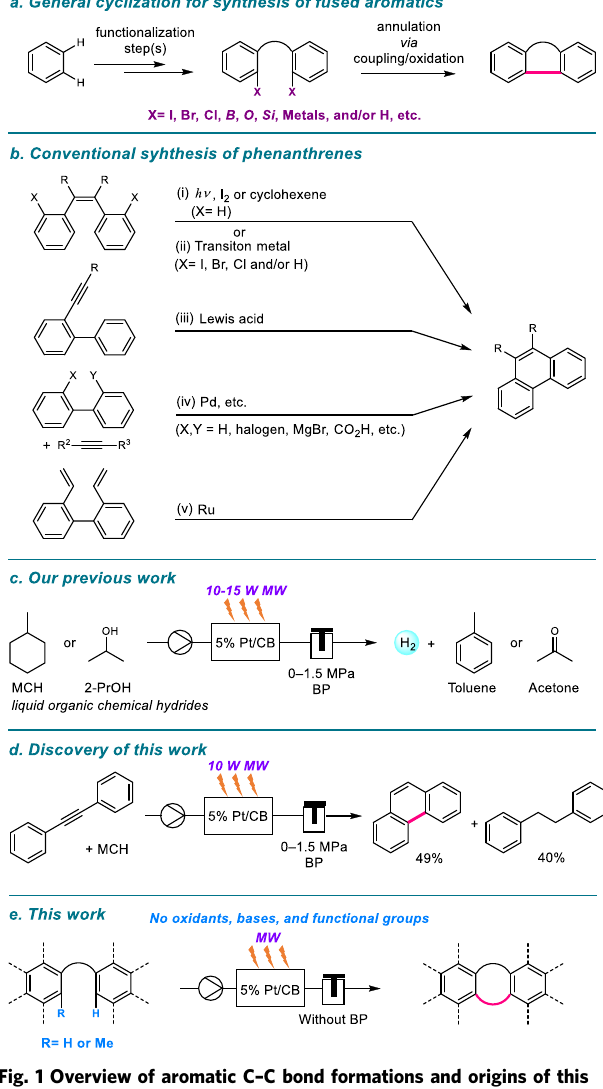
Fig. 1 Overview of aromatic C – C bond formations and origins of this study. a , b Conventional strategy for the synthesis of fused aromatic hydrocarbons. c Pt/CB-catalyzed dehydrogenation reaction of liquid organic hydrates. d , e MW-assisted Pt/CB-catalyzed cyclization reactions (this